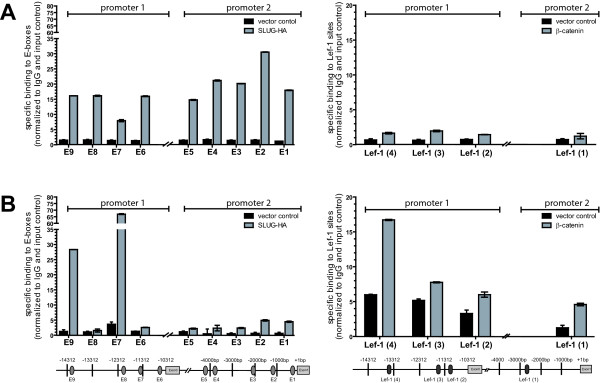
Chromatin-IP analysis of promoter 1 and promoter 2 sites. Hec-1A (A) and ECC-1 (B) cells were transfected with HA-Slug (left panels) or β catenin (right panels) or an empty vector control (pcDNA3). After 48 h cells were fixed, genomic DNA was isolated sheared for Chromatin-IP using antibodies to β catenin or HA. Liberated DNA was subjected to qRT-PCR analysis using primers specific for all E-boxes or Lef-1 binding sites in the L1CAM promoter 1 or promoter 2 regions. Data ± SD of a representative experiment from n = 3 is shown.